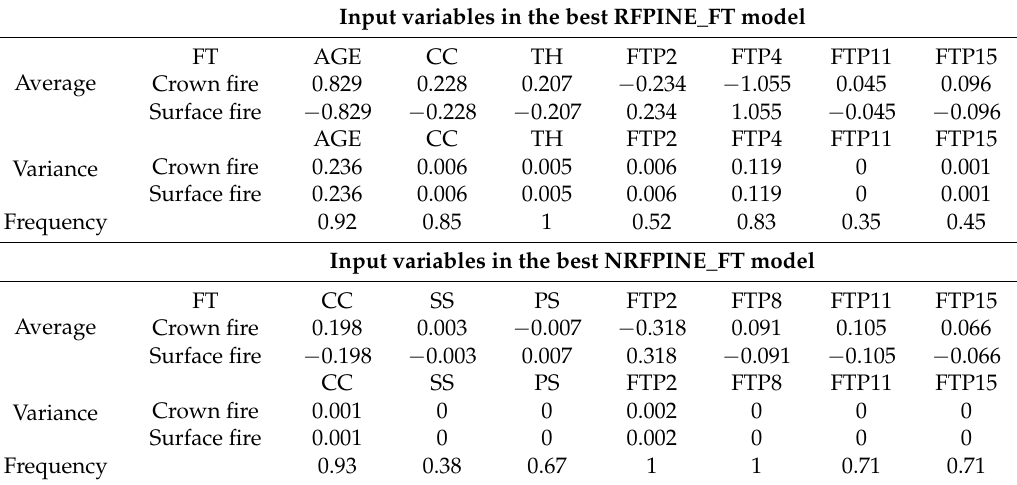
Table 7. Sensitivity analysis of the best models for the classification of Fire Type within reforested and not reforested stands (Pine Group).